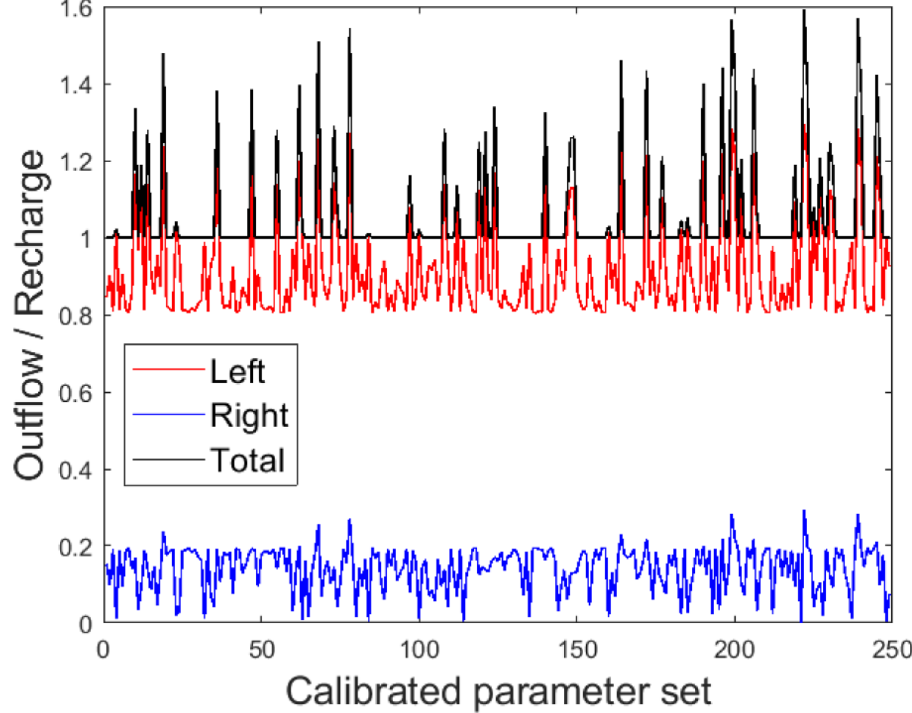
Fig. 6 Outflows through left and right boundaries divided by total recharge for calibrated parameter sets for the hetero- geneous aquifer, f k =